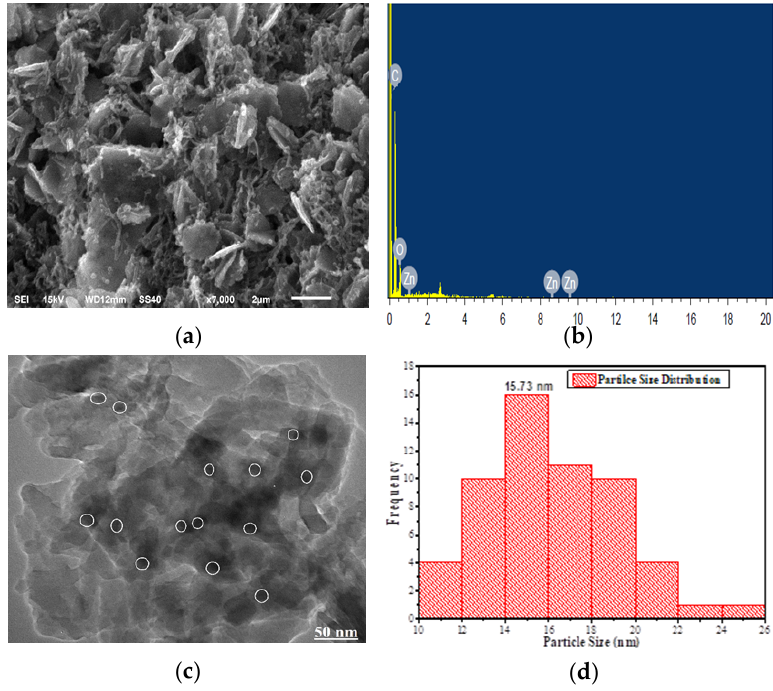
Figure 5. ( a ) SEM image of ZnO@XG nanocomposite ( b ) EDX spectra showing individual